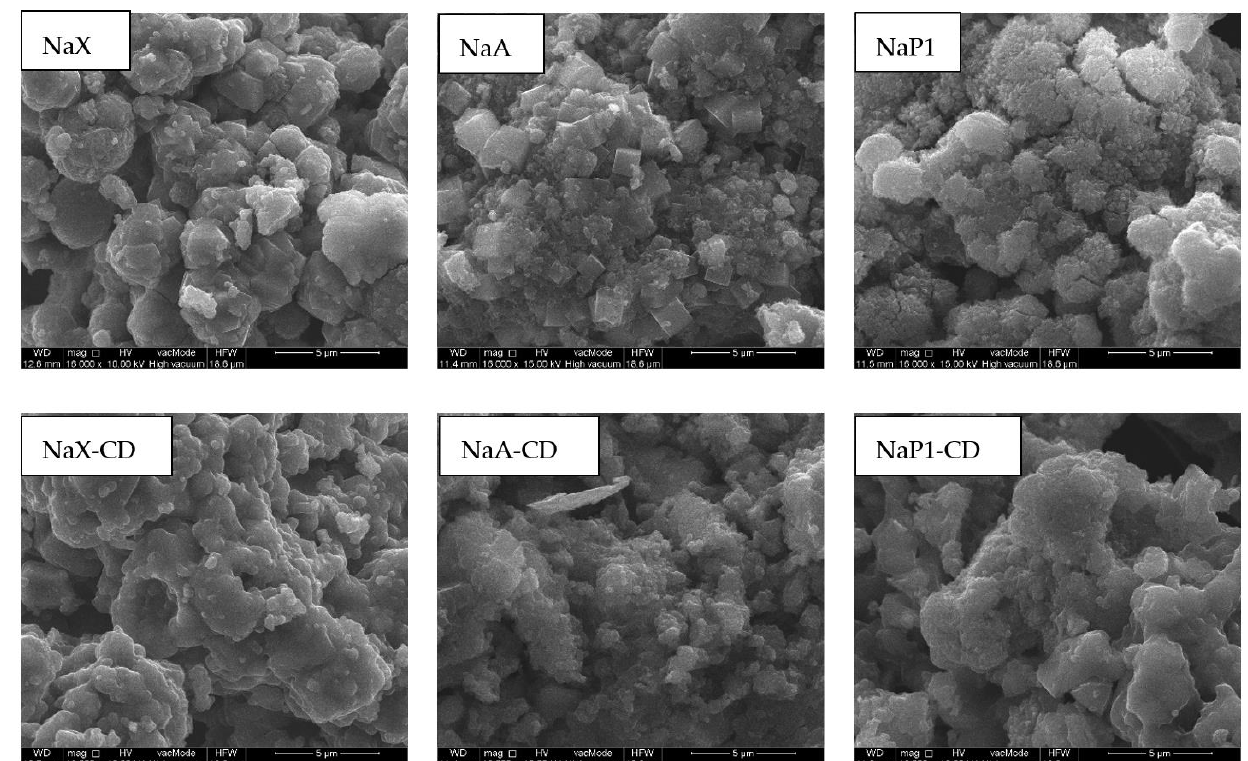
Figure 4. SEM images of NaX, NaA and NaP1 before and after modification with β -CD (magnification 16,000×).